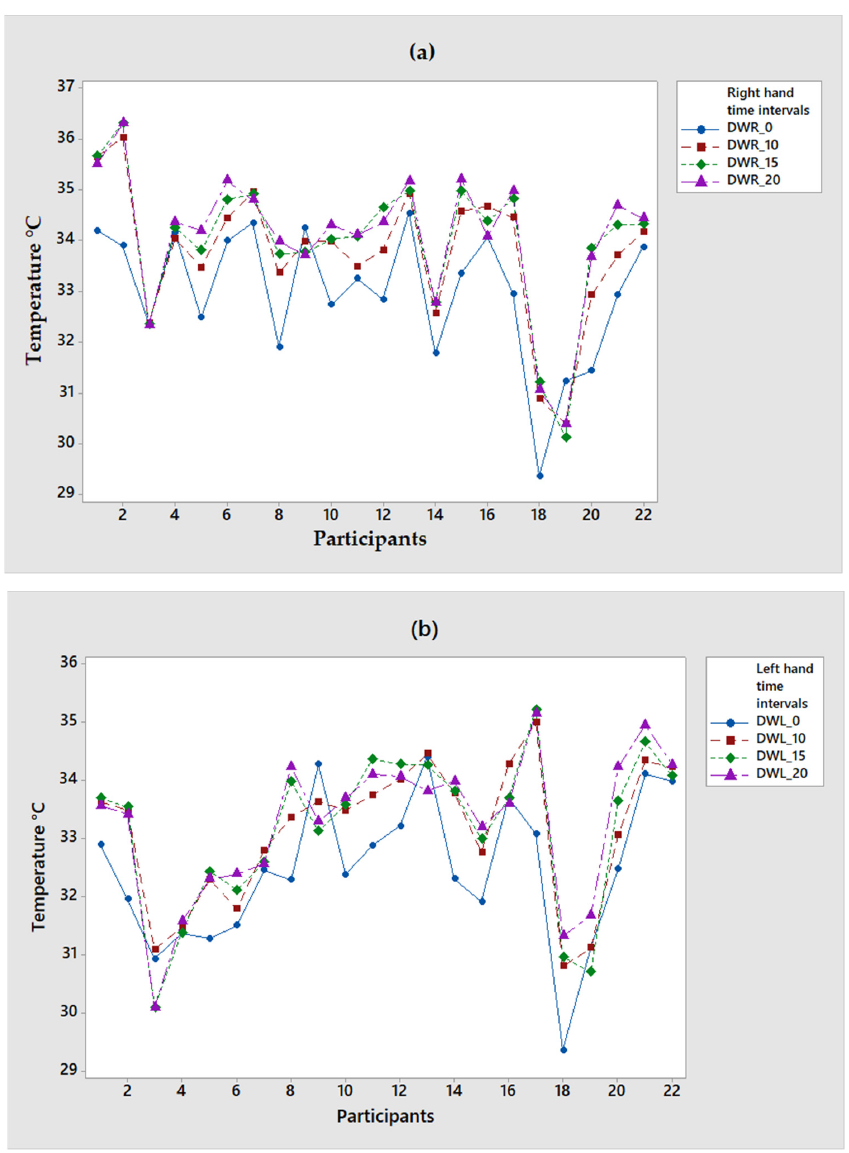
Figure 2. Temperature sample of participants with TS: ( a ) Wrist of the right hand and ( b ) Wrist of the left hand.